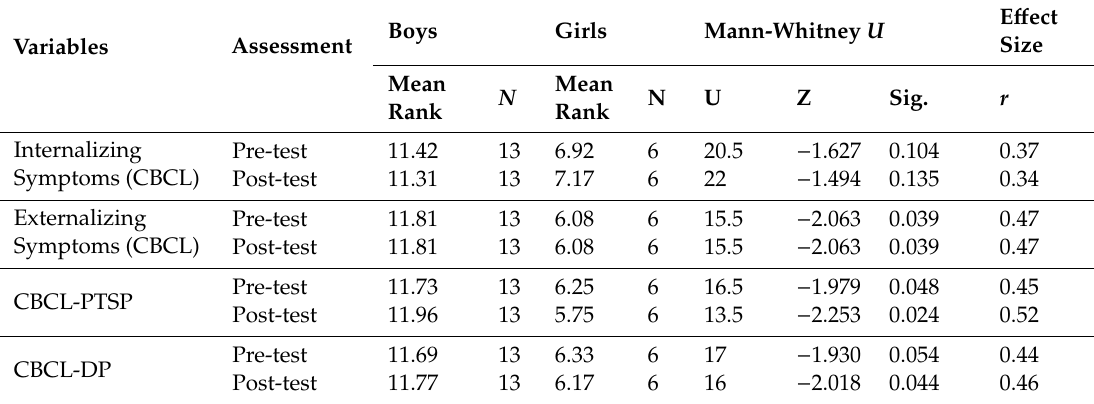
Table 3. Mean ranks for boys ( n = 13) and girls ( n = 6) separately, results of the Mann-Whitney U test and e ff ect sizes associated with di ff erences between